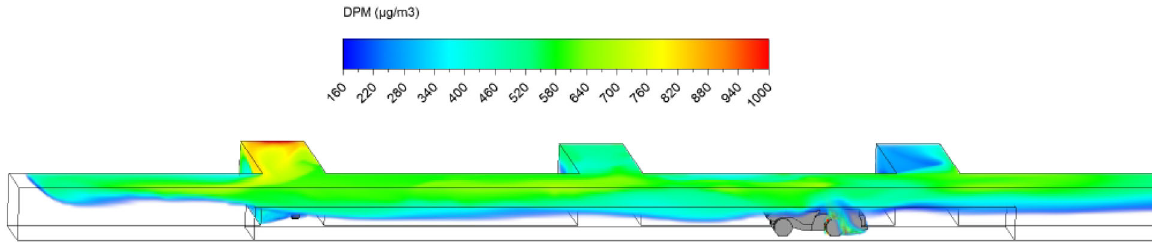
Fig. 18 DPM distributions in scenario 2 during the hauling operation at 225 s